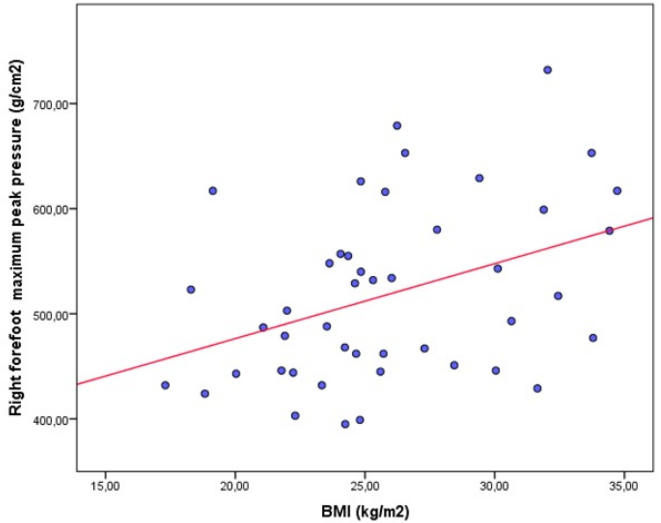
Figure 4. Scatter plot showing a significant positive moderate correlation between the right forefoot maximum peak pressure and BMI in healthy participants.